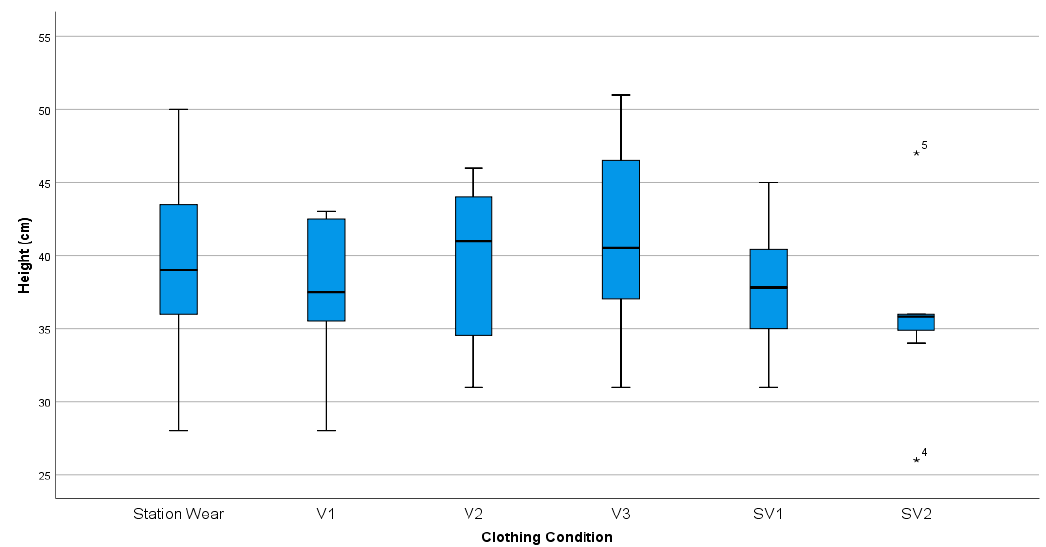
Figure 5. Vertical jump results in each clothing variant.